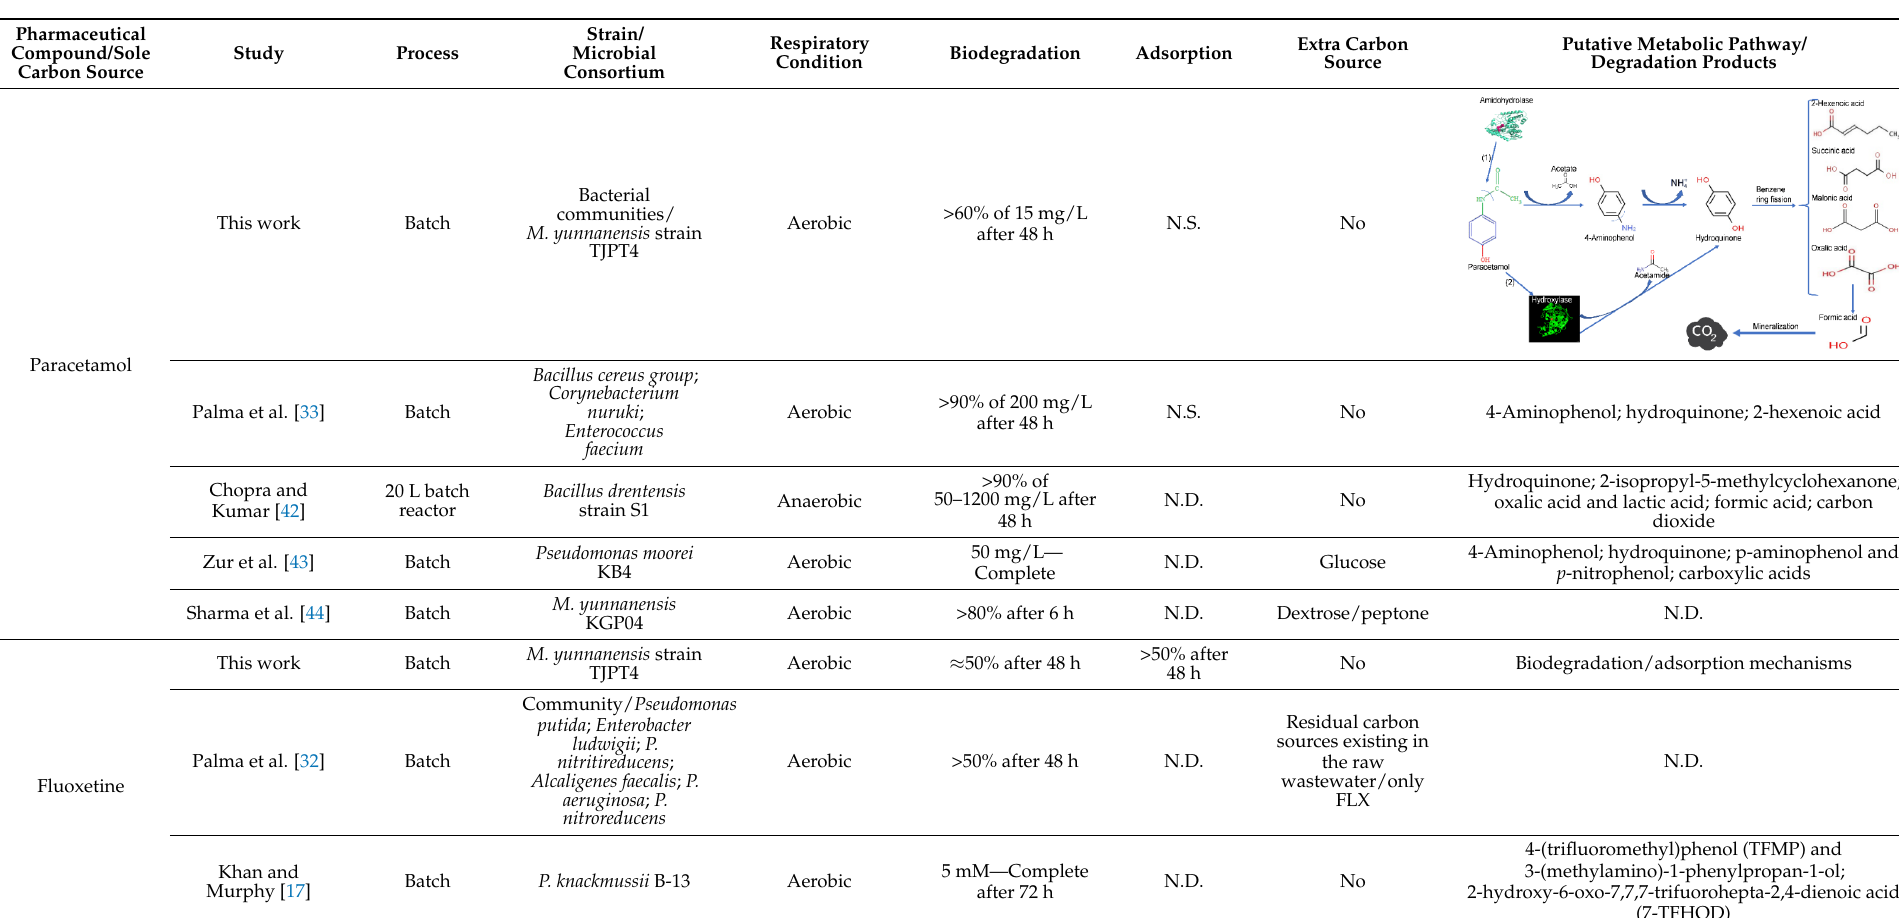
Table 1. Overview of the obtained results and recent literature concerning the biodegradation of paracetamol, FLX and EE2.